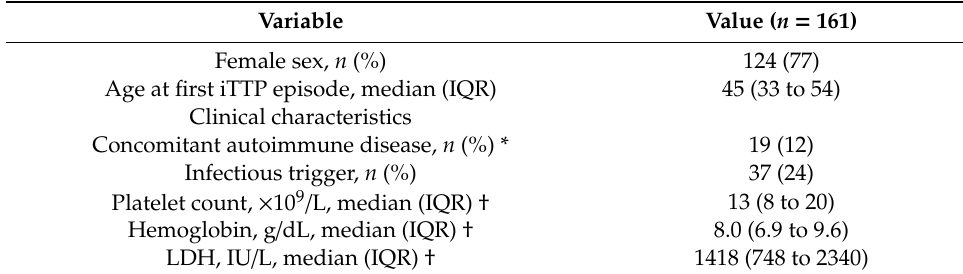
Table 1. Demographic and clinical features of cases included in the study.